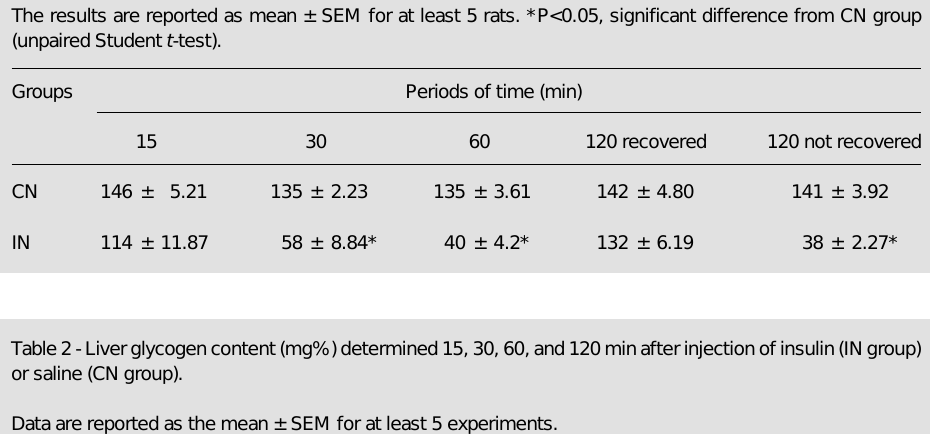
Table 1 - Values of glycemia (mg/dl) determined 15, 30, 60, and 120 min after saline (CN group) or insulin (IN group) administration.